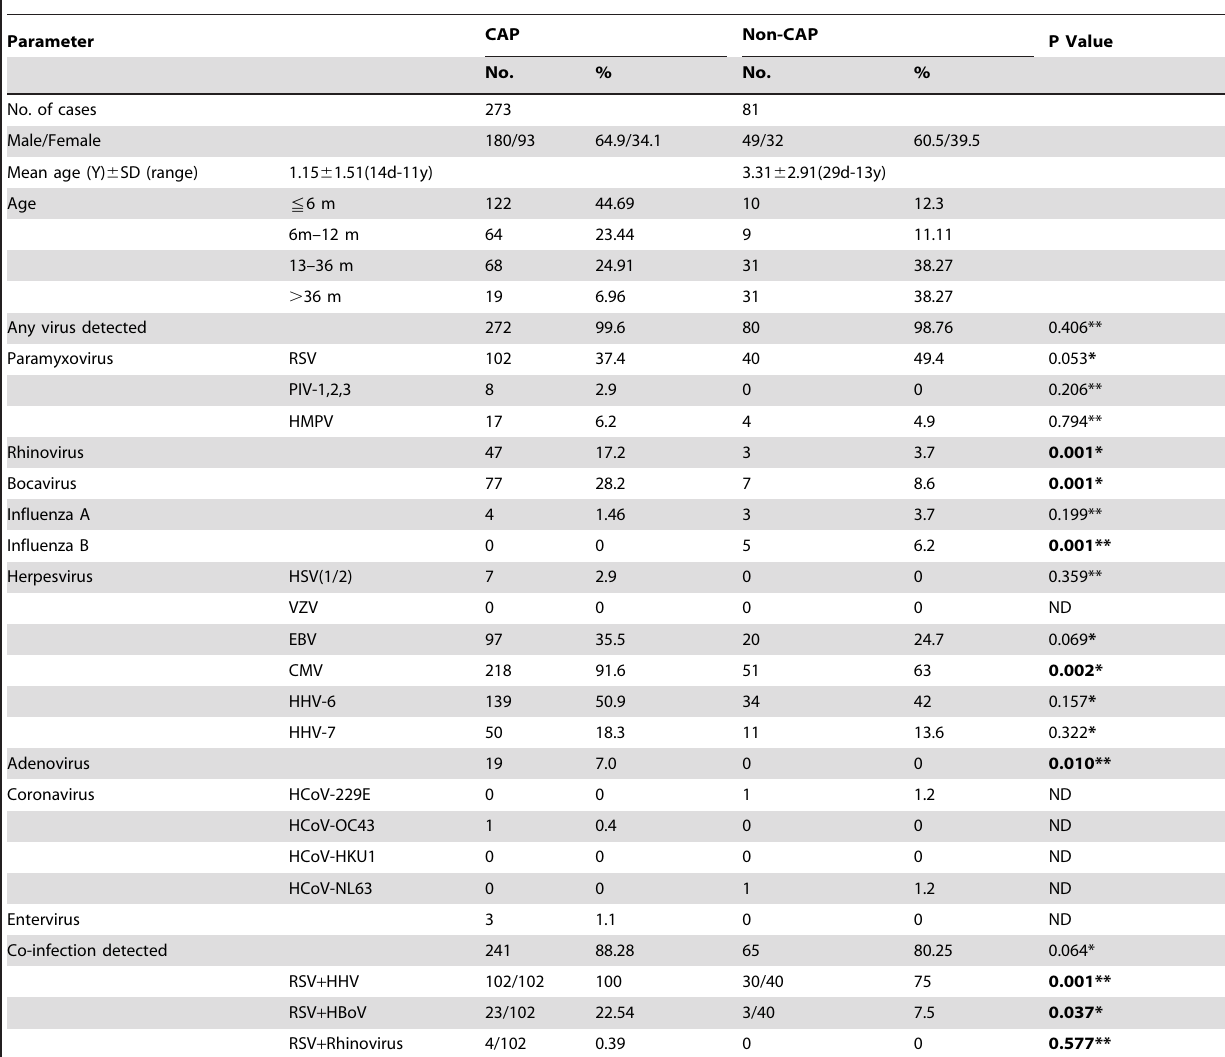
Table 1. Demographic and aetiological data in this study.